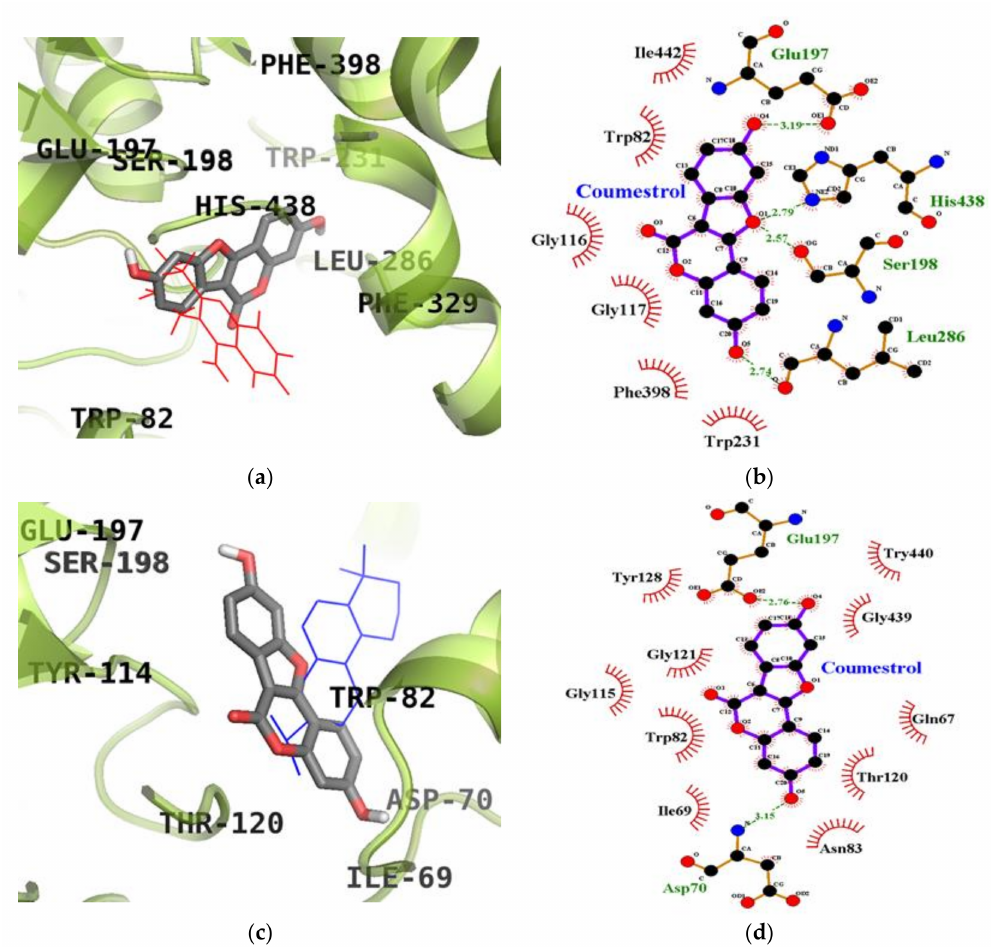
Figure 6. Inhibition mode of coumestrol for the BChE catalytic site with tacrine (red line) ( a ) and allosteric site with cryptotanshinone (blue line) ( c ). 2D ligand interaction diagram of BChE catalytic ( b ) and allosteric ( d ) inhibition by coumestrol. Dashed lines indicate H-bonds. Carbons are in black, nitrogens in blue, and oxygens in